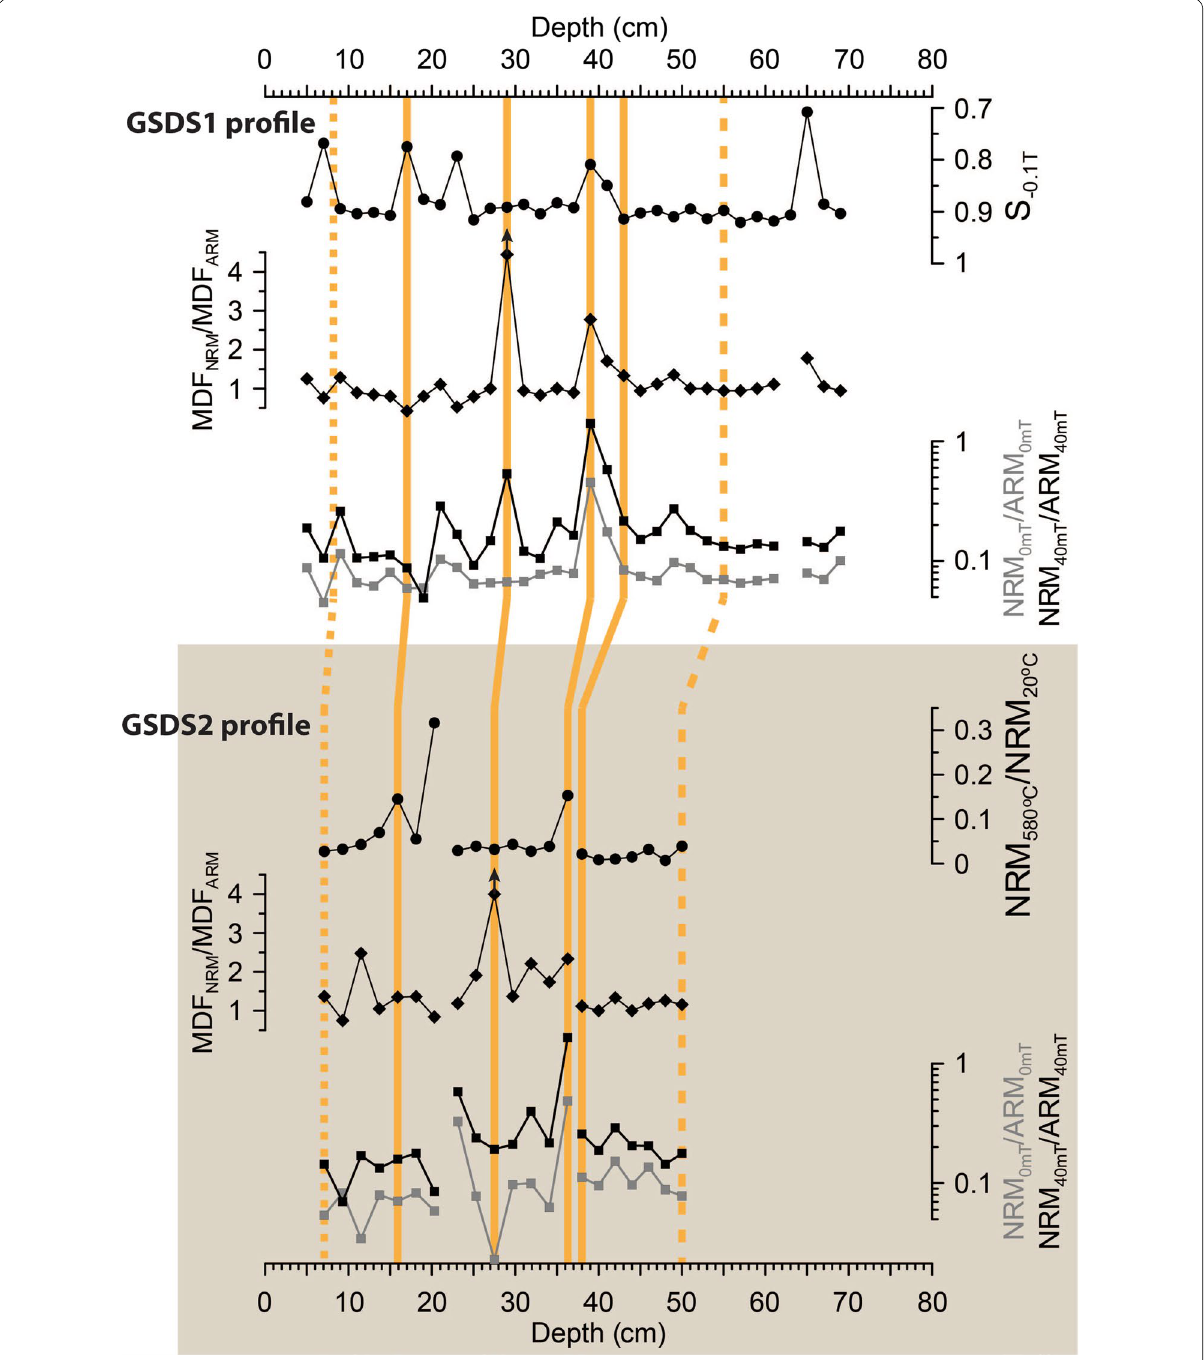
Fig. 11 A possible correlation of stratigraphic levels between GSDS1 and GSDS2 profiles, using rock magnetic parameters such as S NRM 580°C /NRM 20°C ratio, and MDF NRM /MDF ARM ratio, with the variations of NRM 0mT /ARM 0mT and NRM 40mT /ARM 40mT ratios (possible RPI proxies). Upward‑pointing arrows in the MDF NRM /MDF ARM —depth graph denotes “higher than the value of the data point”. This correlation enables the raw depth of the GSDS2 profile to convert into the GSDS1 depth scale (cmcd), with downward shifts by 1.1 cm for the 7.1–20.3 cm raw depth, by (0.9 0.3* x ) cm ( x , distance between the raw depth and 23.1 cm) for the 23.1–36.3 cm raw depth, and by 5.0 cm for the 38.0–50.0 cm raw depth. + See text for